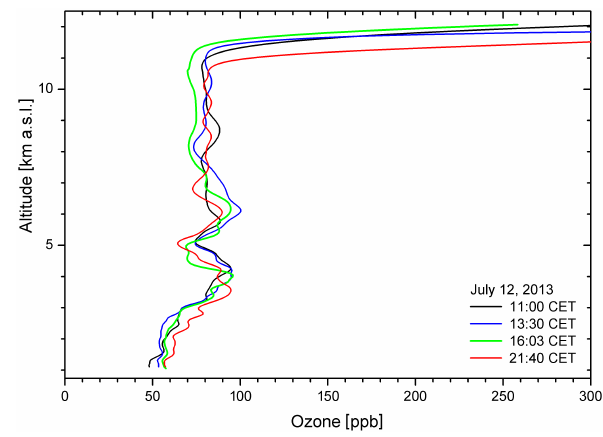
Figure 8. 313nm particle backscatter coefficients selected from the profiles of 12 July 2013. The peak value is given in the text.